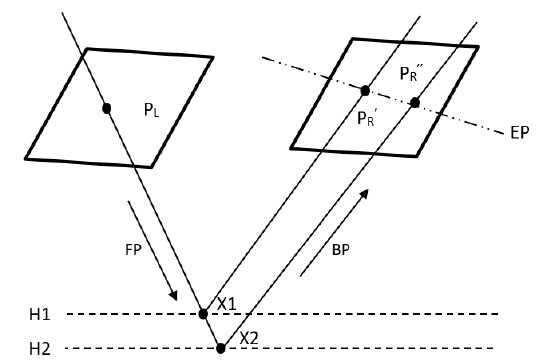
Figure 1. Projection-trajectory method